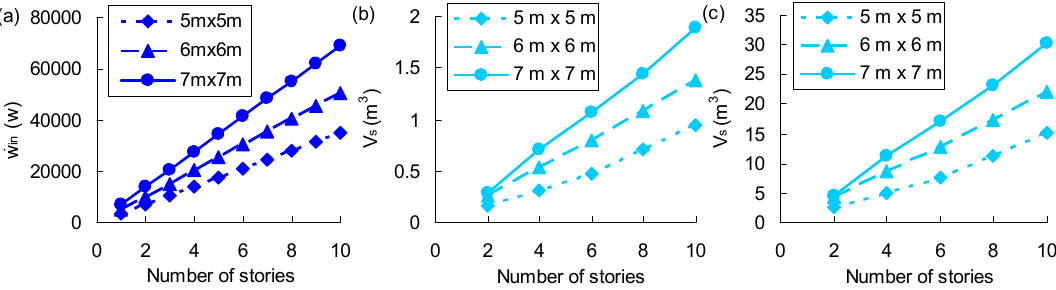
Figure 3. Available energy and volume for storage per each column: ( a ) total available storage energy for a single day; ( b ) volume for d i = 200 mm; ( c ) volume for d i = 800 mm (modified from [8]).